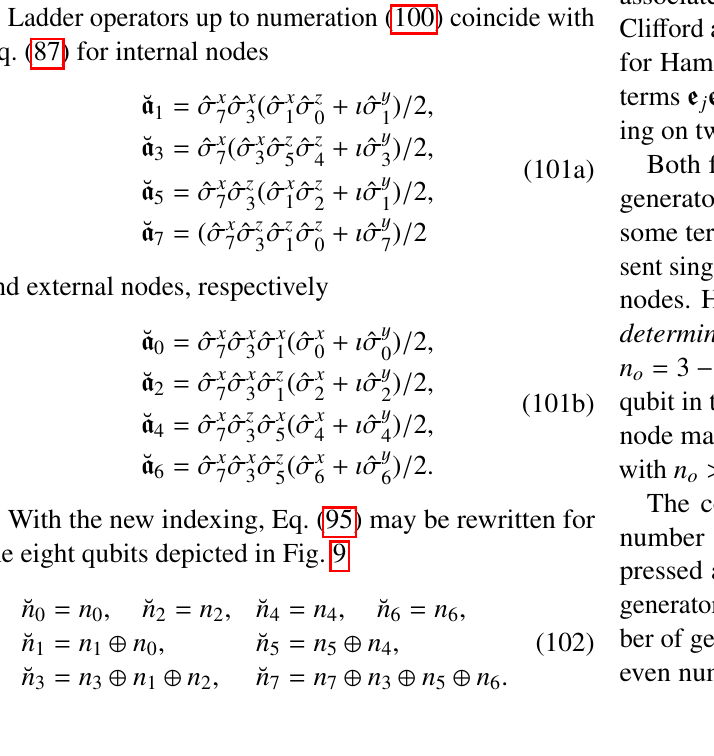
Figure 9: Representation of tree used in Bravyi–Kitaev trans- formation as binary x-z